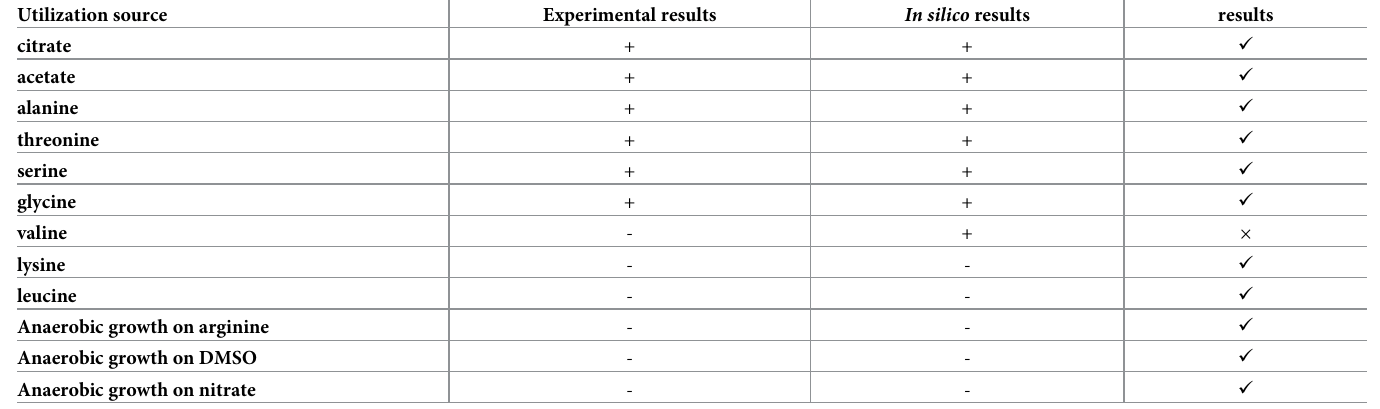
Table 2. Comparison of experimental and predicted behavior of S . ruber